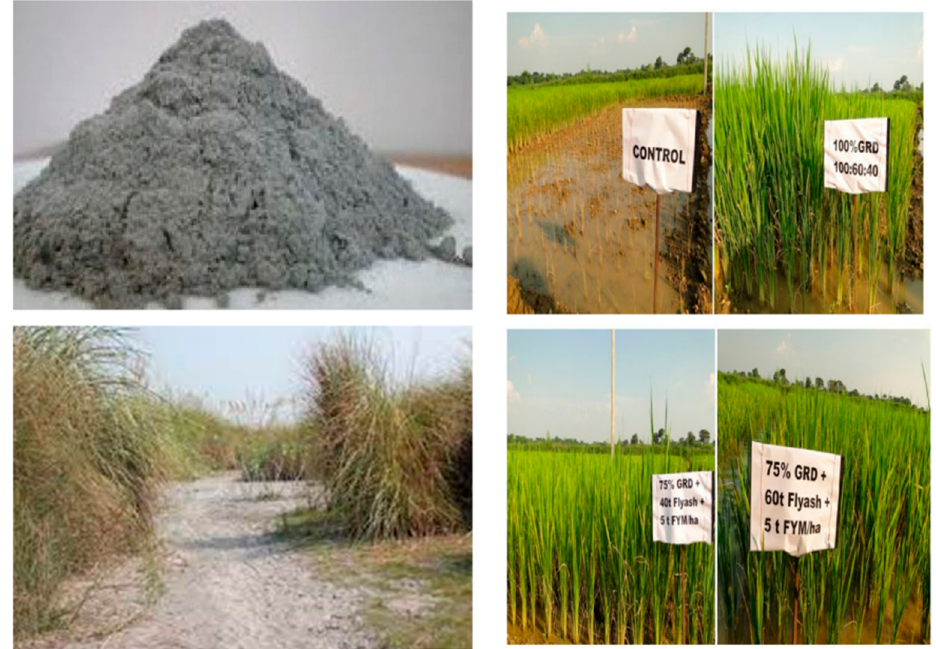
Figure 2. Modified figure of fly ash Industrial-Based Materials for sustainable remediation adapted from [126,127] with due copyright permission under CC license.